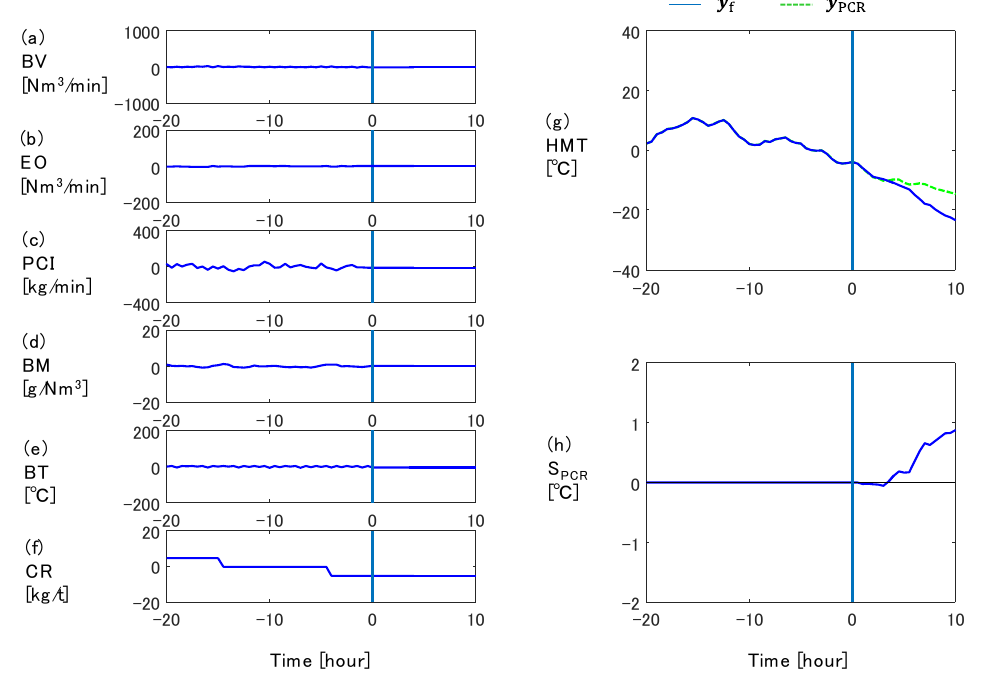
Figure 4. Calculation of free response and step response of HMT: ( a ) blast volume, ( b ) enrichment oxygen flow rate, ( c ) PC flow rate, ( d ) blast moisture, ( e ) blast temperature, ( f ) coke rate, ( g ) hot metal temperature, ( h ) step response of HMT to PCR.